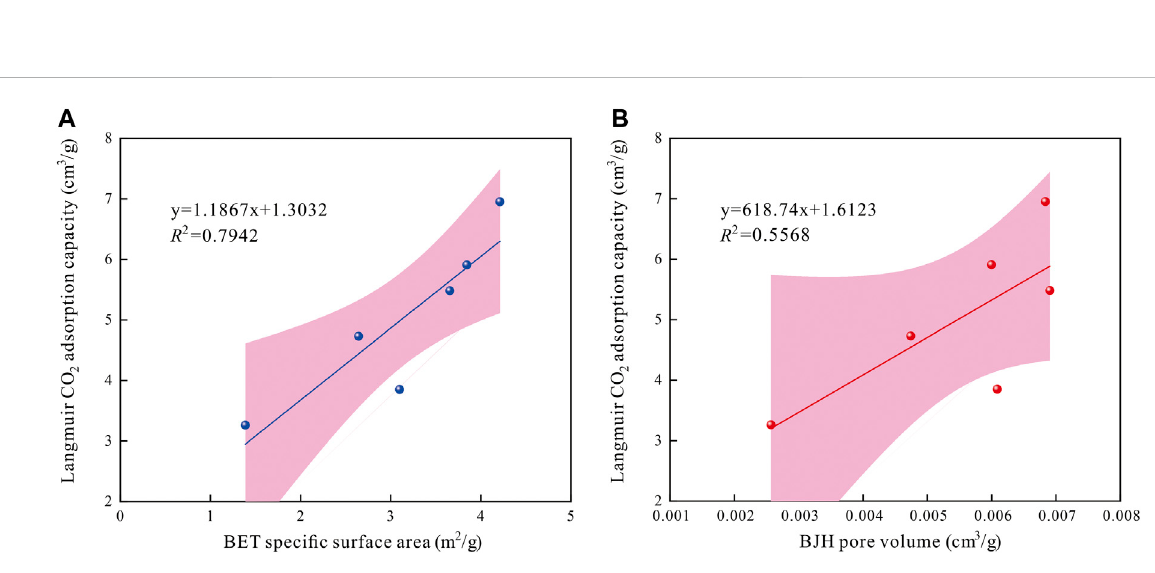
FIGURE 10 Relationships between pore structure parameters vs. Langmuir CO 2 adsorption capacity in